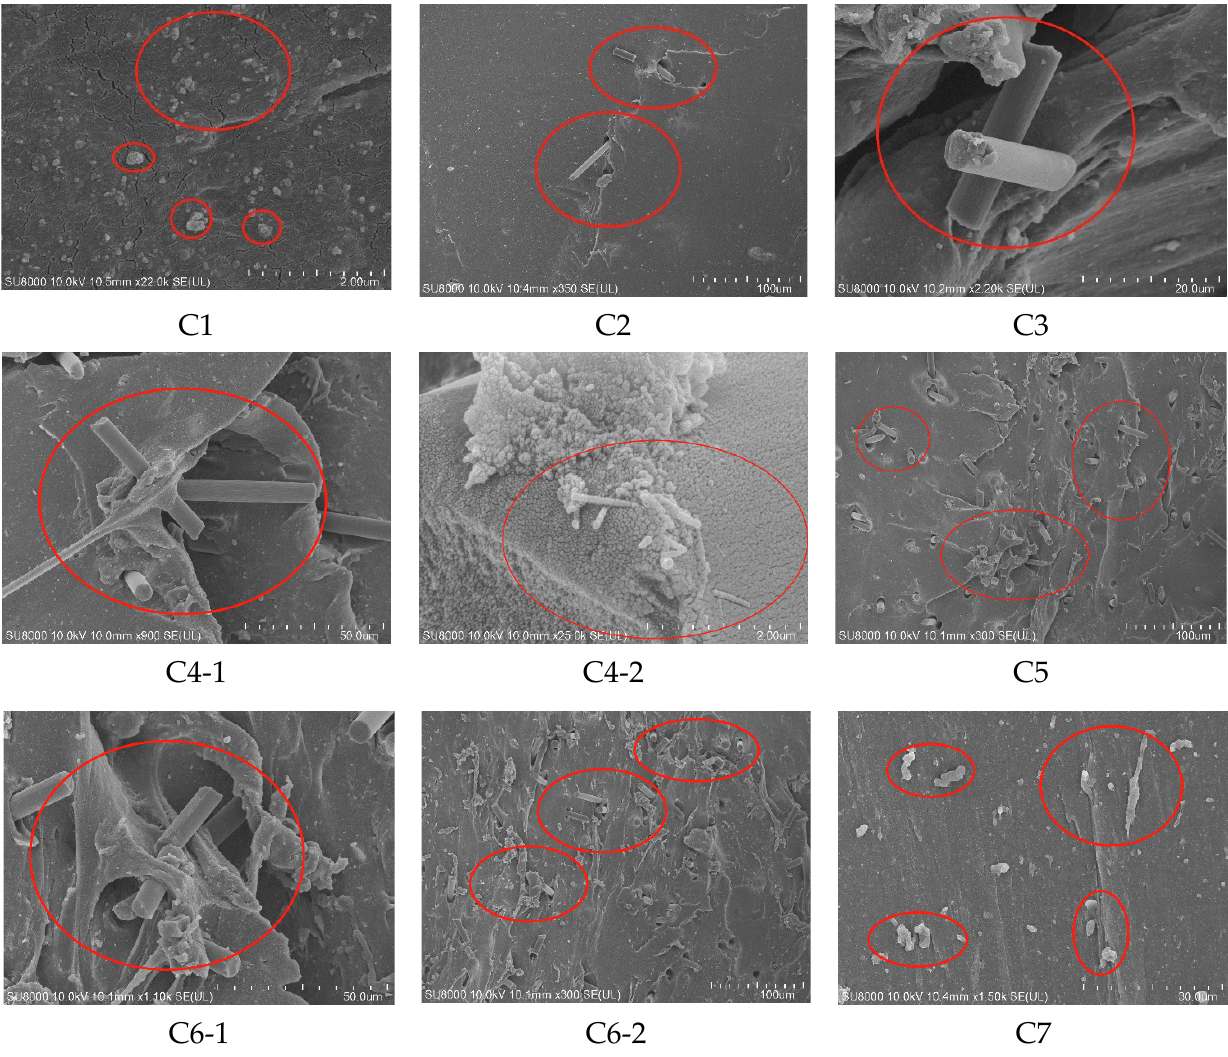
Figure 4. SEM. C1 ‐ C7 are 7 groups of rubber. Figure 4. SEM. C1 – C7 are 7 groups of